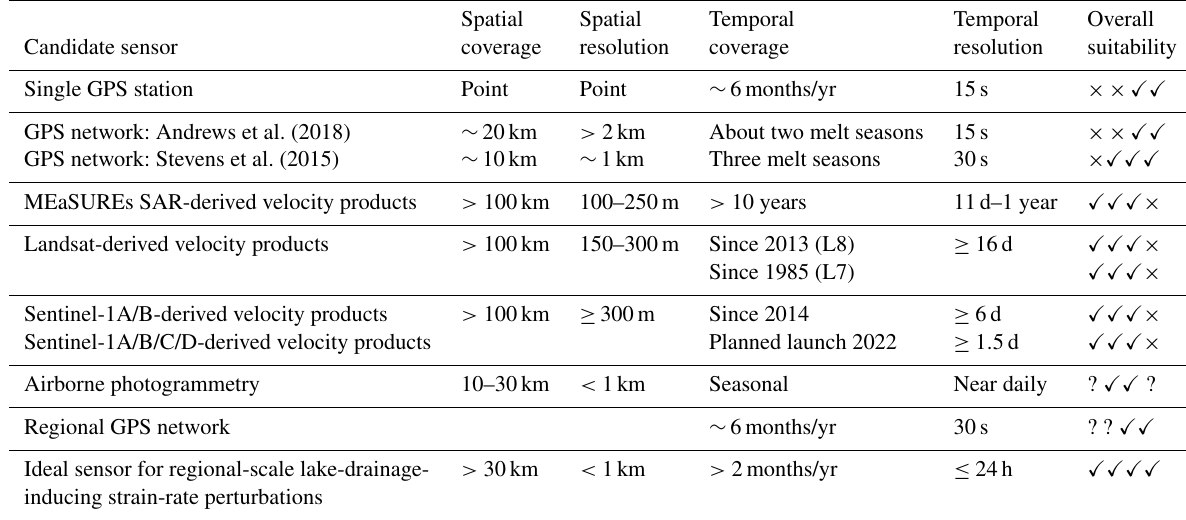
Table 1. Candidate methods for transient strain-rate detection, along with their characteristics in spatial coverage, spatial resolution, temporal coverage, and temporal resolution. Checks and strike marks in the last column indicate whether the method is sufficient, in each respective category, to resolve hypothesized lake drainage precursor events at the regional scale. Question marks denote open avenues for